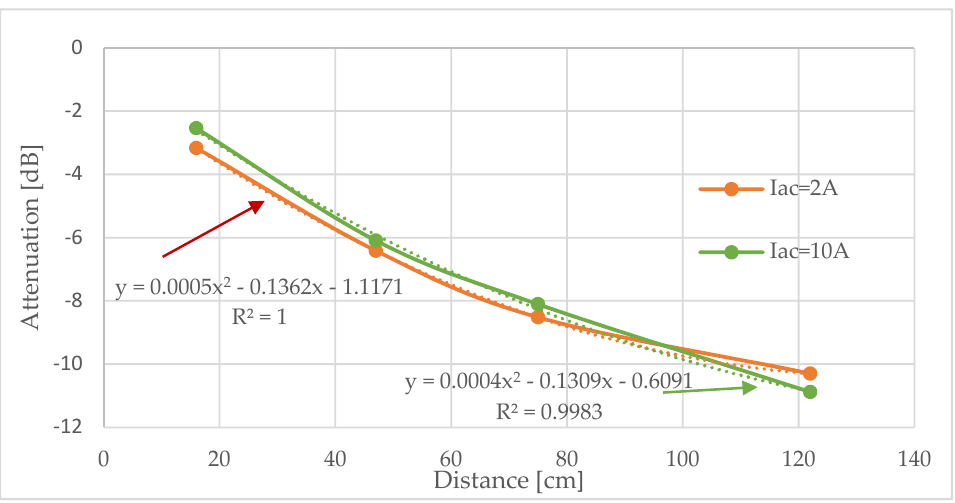
Figure 12. Experimental torsional wave attenuation as a function of the distance.